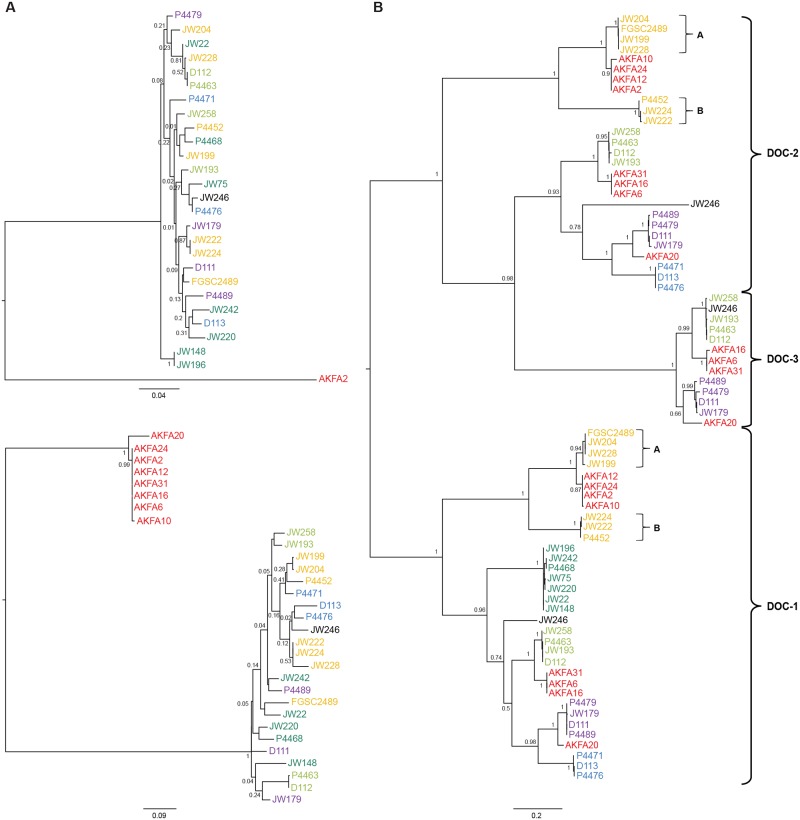
Phylogenetic analyses of the predicted proteins encoded by genes associated with genomic rearrangements revealed transspecies polymorphisms at DOC-1 and DOC-2/DOC-3.Coding sequences from 26 N. crassa wild Louisiana isolates and up to eight N. discreta wild isolates were used to build maximum likelihood phylogenetic trees for (A) NCU07190 (top) and NCU07193 (bottom) and (B) NCU07191 (doc-1) and NCU07192 (doc-2; doc-3), using the default pipeline from Phylogeny.fr [99]. Bootstrap values are given for each node. Black bars indicate substitution rates. CGH1 isolates are shown in orange (subgroups A and B are indicated), CGH2 isolates are shown in light green, CGH3 isolates are shown in blue, CGH4 isolates are shown in purple, and CGH5 isolates are shown in dark green. The isolate JW246 did not produce spores and is therefore shown in black. N. discreta isolates are shown in red. Note nesting of N. discreta isolates within N. crassa lineages for NCU07191 (doc-1) and NCU07192 (doc-2; doc-3), but not for NCU07190 or NCU07193 (shown in panel A); see S1 Tree for Nexus file.